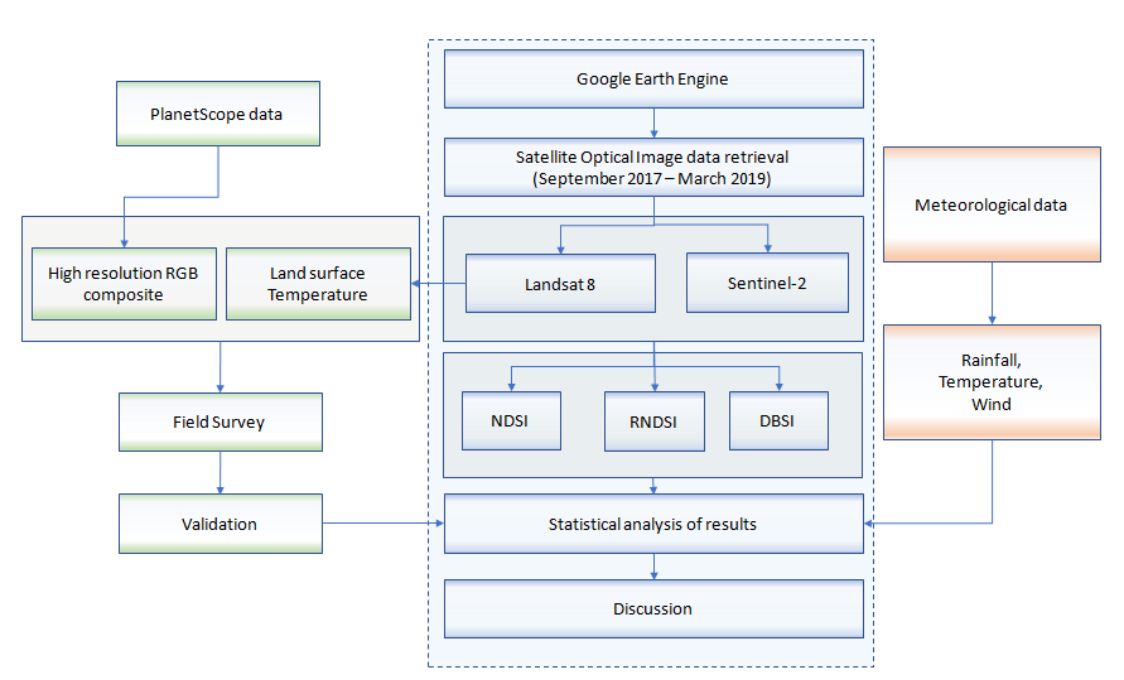
Figure 5. Flowchart of the study employed for the detection of soiling on PV solar panels.